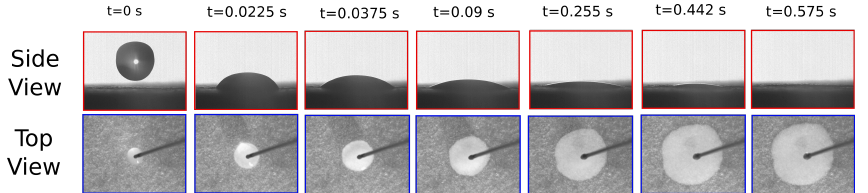
Figure 7. Evolution of the liquid cap and the wetted area with time for the spreading of a WE18 droplet on a Sartorius 388 filter paper, as observed from the side and top cameras, respectively. The dimensions of the side view and the top view images are 7.4 mm × 5.6 mm and 18.3 mm × 13.8 mm,